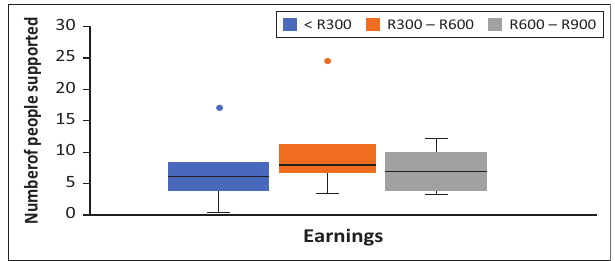
FIGURE 2: Boxplots to show the relationship between the daily earnings of the participant and the number of people they support. No participant earned more than R900.00 per day. Boxes represent the range of number of people supported between the first and third quartiles with the median indicated by the bar running through the box. The whiskers represent the minimum (below) and maximum (above) number of people and outlier results are indicated by dots separate to the whiskers. TABLE 1: Median rank of types of work versus income category where the closest to 1 was the top rank and the closest to 4 was the lowest rank. Earnings Scrap metal Garden refuse Transport Other